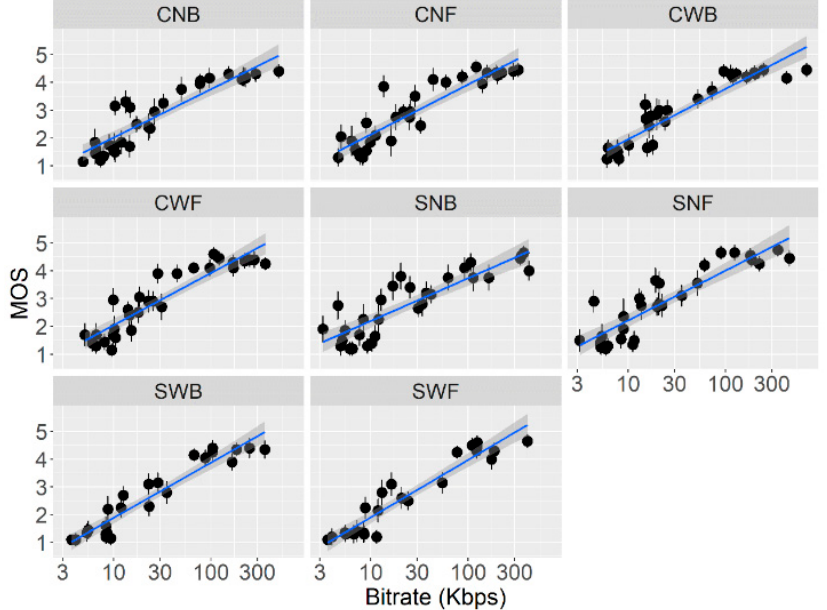
Figure 5. MOS score versus Bitrate for various conditions. The black dots in the scatter plots represent the data collected for each of the LF rendering conditions as defined in Table 1 such that each black dot presents a paired measurement of two variables (i.e., Bitrate and MOS), while the blue lines are the lines of best fit for each set of LF rendering conditions.